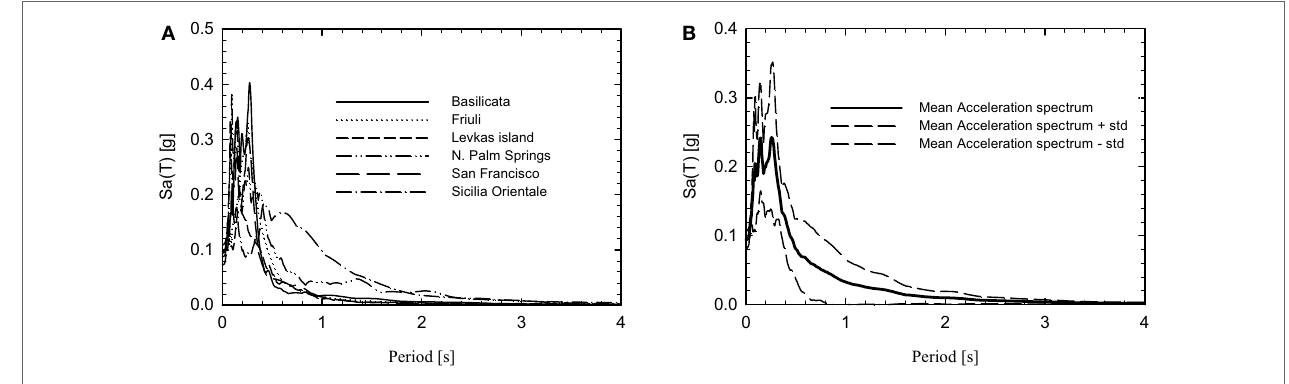
FigUre 5 | (a) Elastic acceleration response spectra and (B) mean acceleration response spectrum.